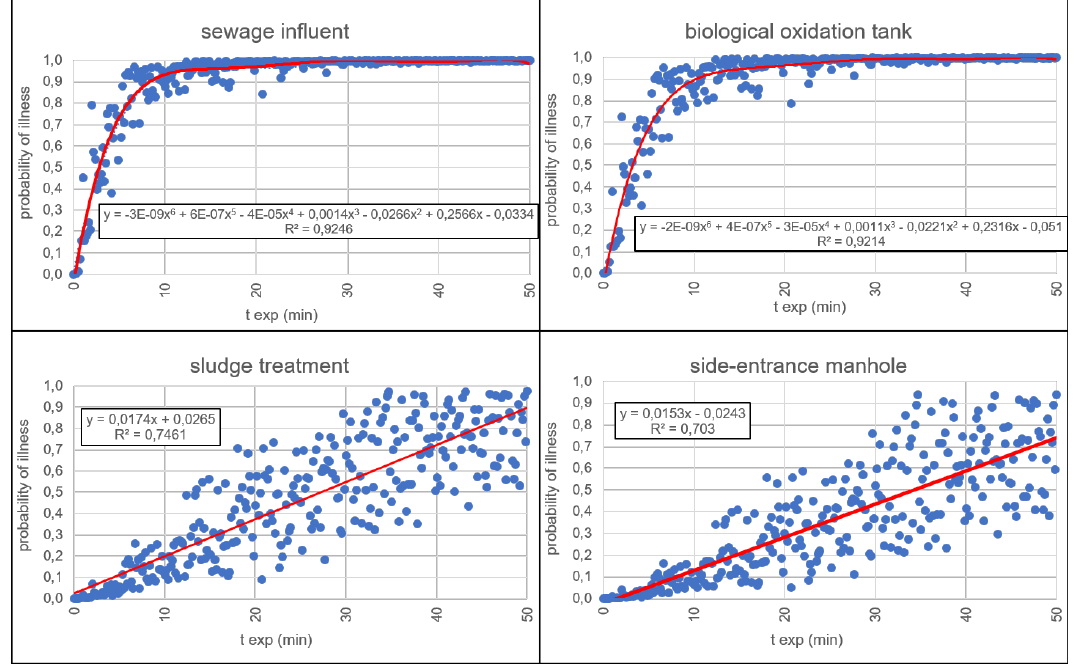
Figure 2. The probability of illness P ill as a function of the exposure time ( t exp ) for each exposure event in the different areas over an interval of time long enough (50 min) in order to appreciate the trend lines. In the equations, y corresponds to the probability of illness and x to t exp .